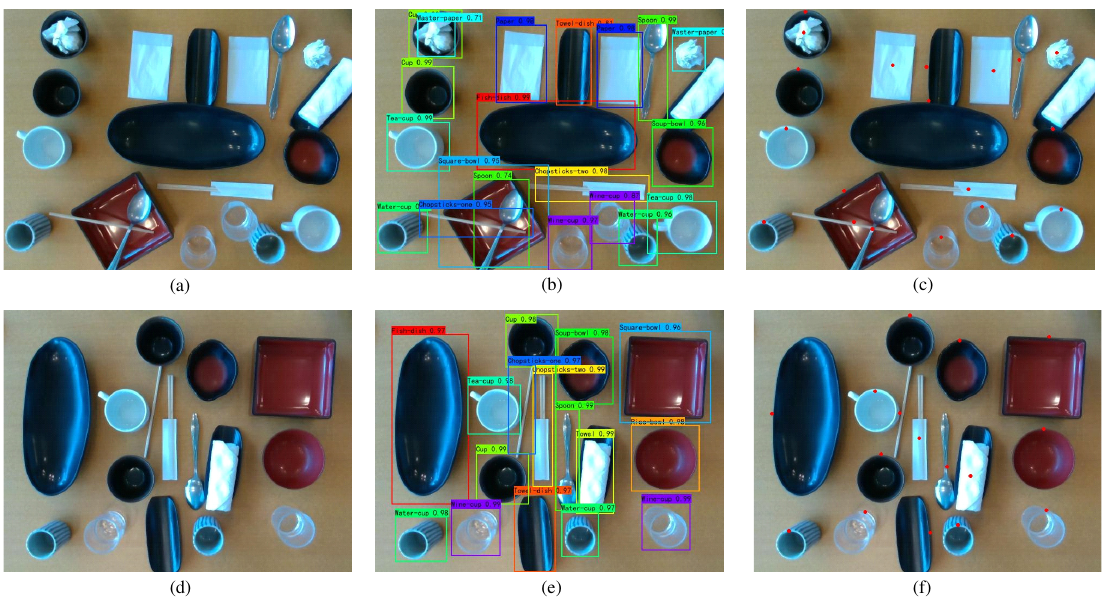
Figure 9. Example of dish detection and catch point extraction. ( a ) Is one of Dish’s images, ( b ) is the detection result of ( a ), and ( c ) is the catch point extraction image of ( a ). ( d ) Is one of Dish’s images, ( e ) is the detection result of ( d ), and ( f ) is the catch point extraction image of ( d